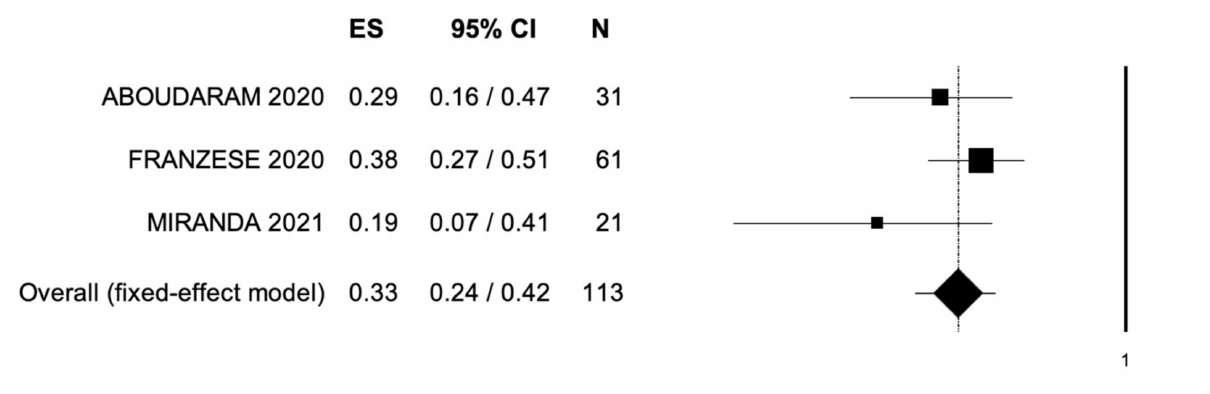
Figure 3. Forest plot showing the event rate for 2-year progression-free survival. ES, effect size; CI, confidence interval. (I 2 = 25.39, p = 0.262.)